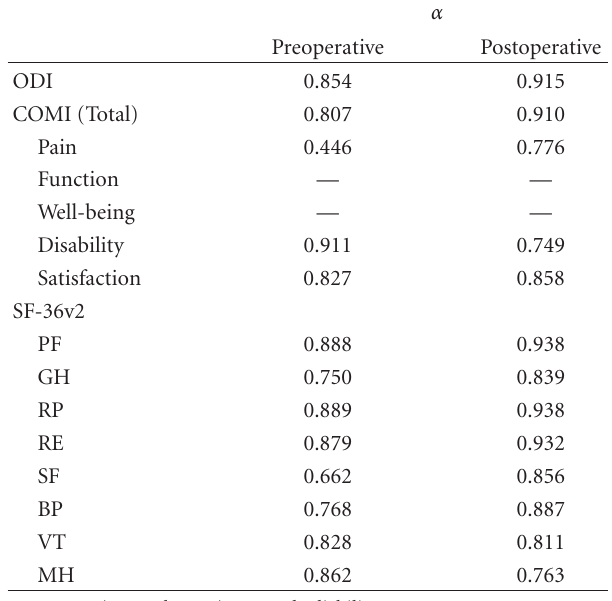
Table 3: Internal Consistency (cronbach’s alpha coe ffi